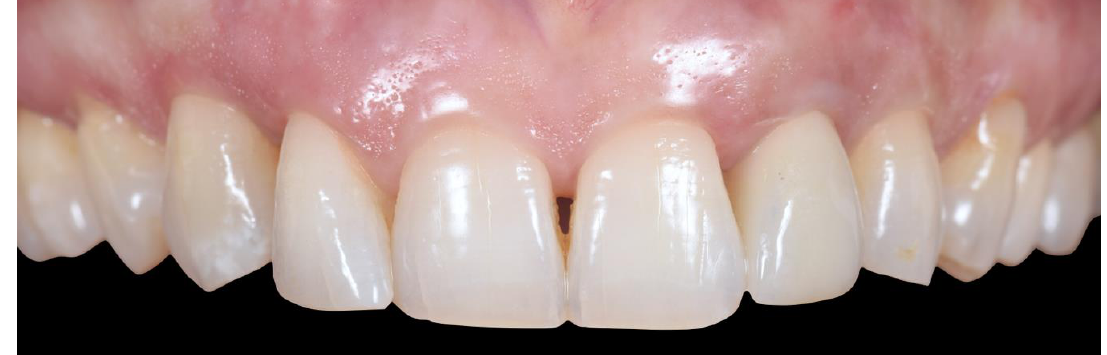
Figure 28. Clinical image. One year post loading.